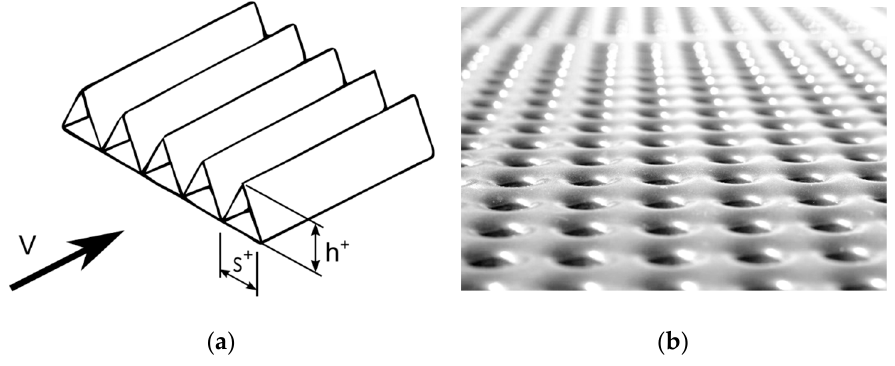
Figure 27. Technologies to reduce turbulent drag: ( a ) riblets; ( b ) dimples.